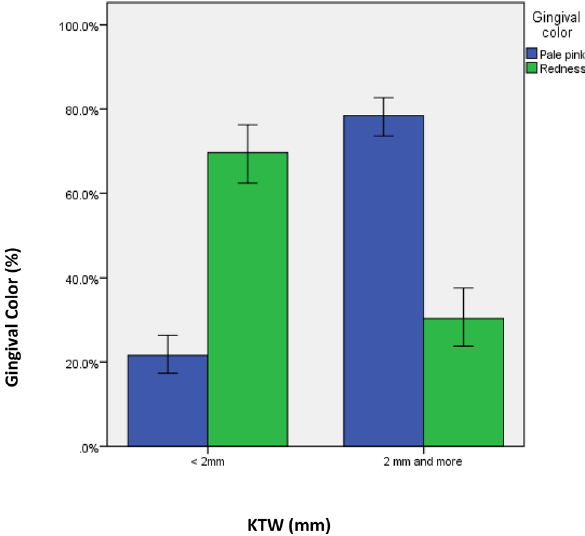
Figure 3. Percentage of gingival color (pale pink vs. redness) based on keratinized tissue width